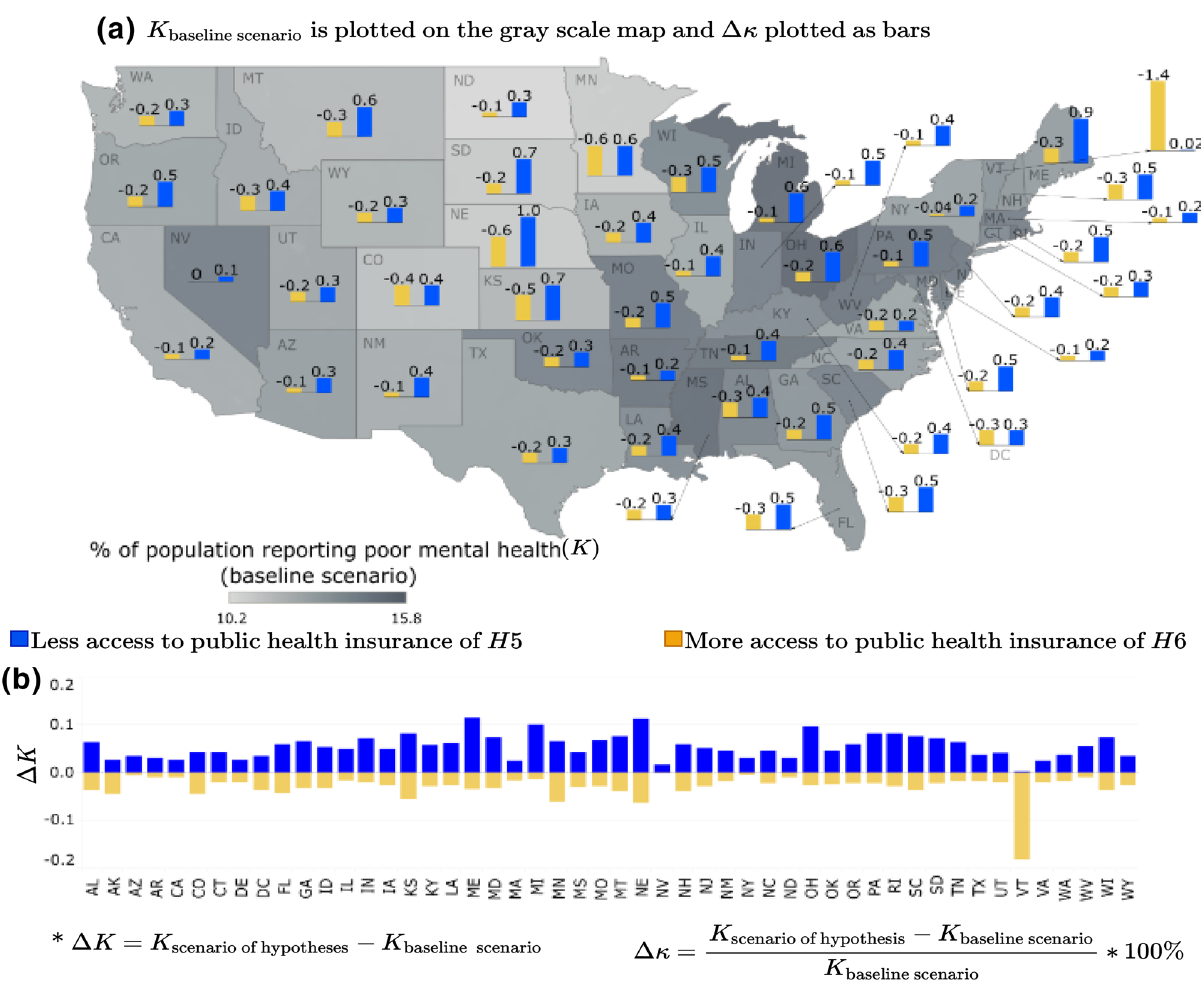
Figure 5. Access to public health insurance scenarios for % of adults aged > 18 years reporting poor mental health for > 14 days ( K ): ( a ) �κ is plotted as the bars and K for base line scenario is plotted as gray scale intensity on the US map; and for ( b ) (cid:31) K is plotted. The maps are created using Tableau 2021.2 (Tableau 2021.2 New Features) and Adobe Illustrator (Software and services for creative business teams | Adobe Creative Cloud for